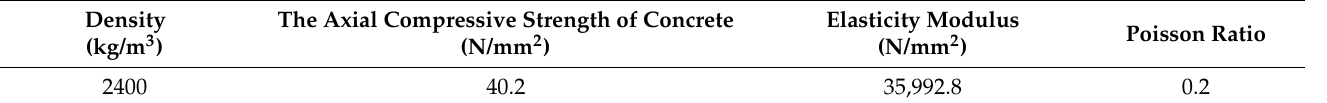
Table 1. Material properties of C60 concrete at room temperature.